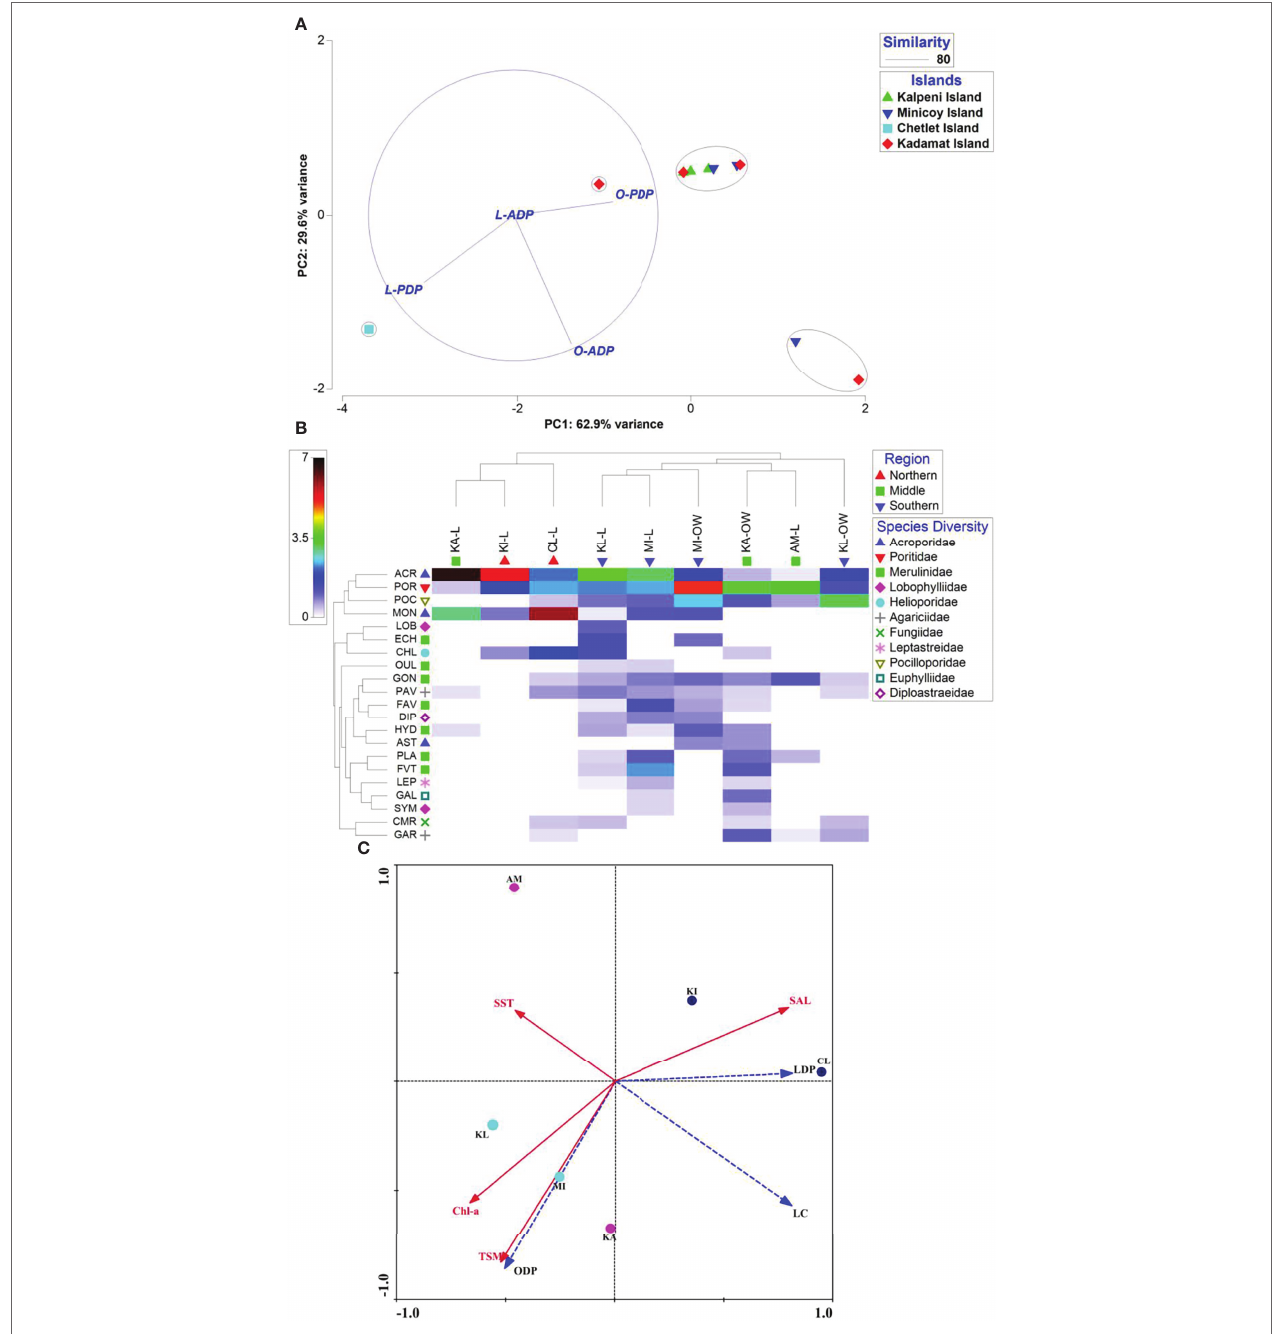
FIGURE 2 | Multivariate analyses. (A) PCA and Bray-curtis cluster analysis based on the abundance of Drupella cornus on coral colonies. L Lagoon region; O Openwater Reef slope region; PDP Drupella cornus on Pocillopora verrucosa; ADP Drupella cornus on Acropora sp.; (B) Shade plot combined with Bray-Curtis cluster analysis showing coral species occurrence with respect to the Islands. MI, Minicoy Is.; CL, Chetlet Is.; KA, Kadamat Is.; AM, Amini Is.; KL, Kalpeni Is.; OW, Openwater Reef slope region; L Lagoon region; ACR Ac ropora sp.; POR, Porites sp.; GON, Goniastrea sp.; PLA, Platygyra sp.; LOB, Lobophyllia sp.; OUL, Oulophyllia sp.; HYD, Hydnophora sp.; CHL, Coral Heliopora ; PAV, Pavona sp.; ECH, Echinopora sp.; FAV, Favia ( Dipsastraea ) sp.; FVT, Favites sp.; CMR, Coral Mushroom; LEP, Leptastrea sp.; MON, Montipora sp.; DIP, Diploastrea sp.; POC, Pocillopora sp.; GAR, Gardineroseris sp.; GAL, Galaxea sp.; SYM, Symphyllia ( Lobophyllia ) sp.; AST, Astreopora sp; (C) Redundancy Analysis Triplot visualizing the distribution of live coral cover and Drupella cornus abundance in relation to various environmental variables (SST, salinity, chlorophyll- a and TSM). Red arrows indicate the environmental variables and blue coloured arrows represent the biological variables [live coral cover (LC), Offshore Drupella cornus abundance (ODP) and Lagoon Drupella cornus abundance (LDP)]. The circles indicates respective Islands (MI & KL, Minicoy and Kalpeni Islands of southern part of Lakshadweep; KA & AM, Kadamat and Amini Islands of middle part; CL & KI, Chetlet and Kilthan Islands of Lakshadweep